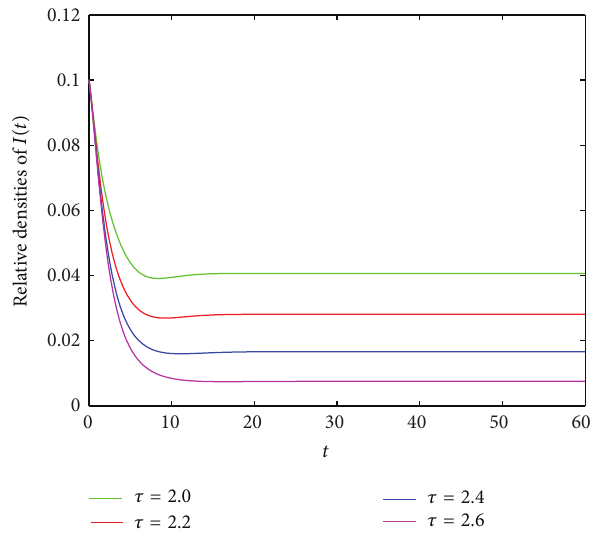
Figure 5: Evolution of 𝐼(𝑡) for different 𝜏